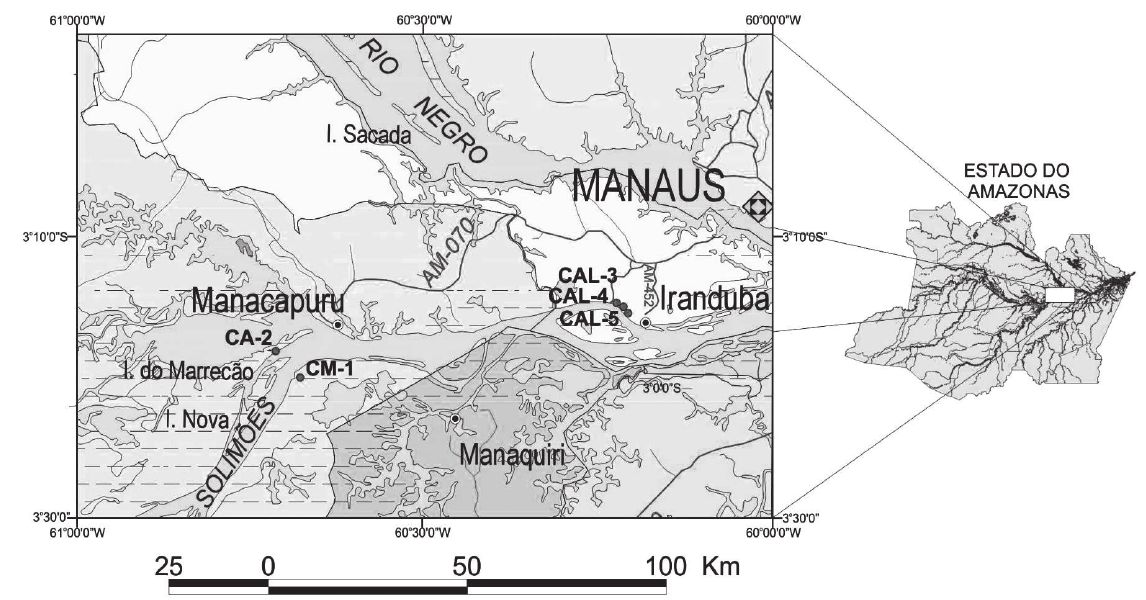
Figura 1. Localização geográfica das áreas de estudo. CM-1: Perfil 1, na Costa do Marrecão; CA-2: Perfil 2, no Cabaleana; CAL-3: Perfil 3, no Caldeirão; CAL-4: Perfil 4, no Caldeirão; e CAL-5: Perfil 5, no